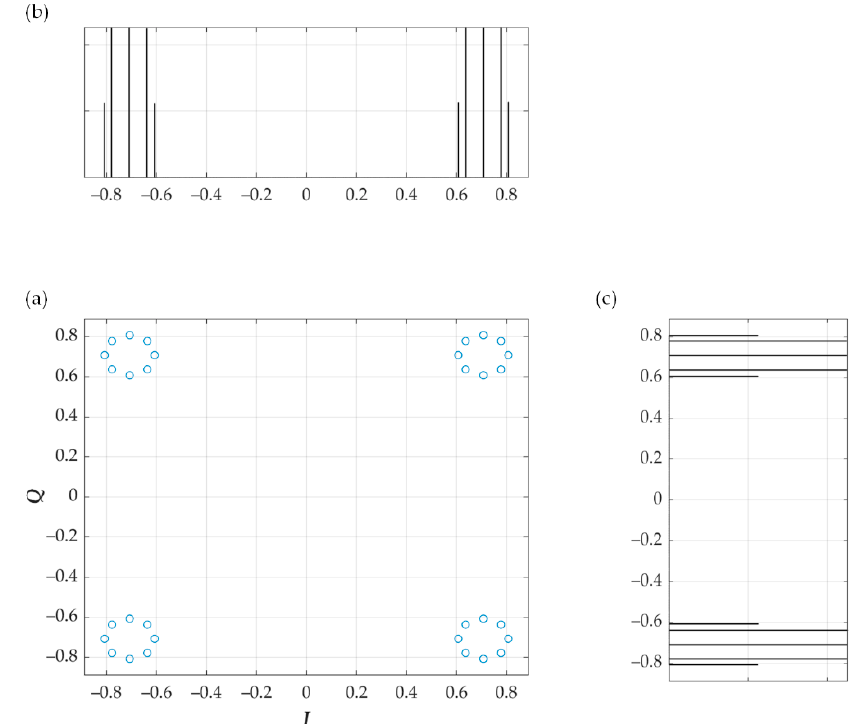
Figure 7. ( a ) Constellation ( b ) in-phase and ( c ) quadrature histograms for 4 quadrature amplitude modulation (QAM) cover and drift correction modulation (DCM) covert channel with M = 4 and for fixed parameters.